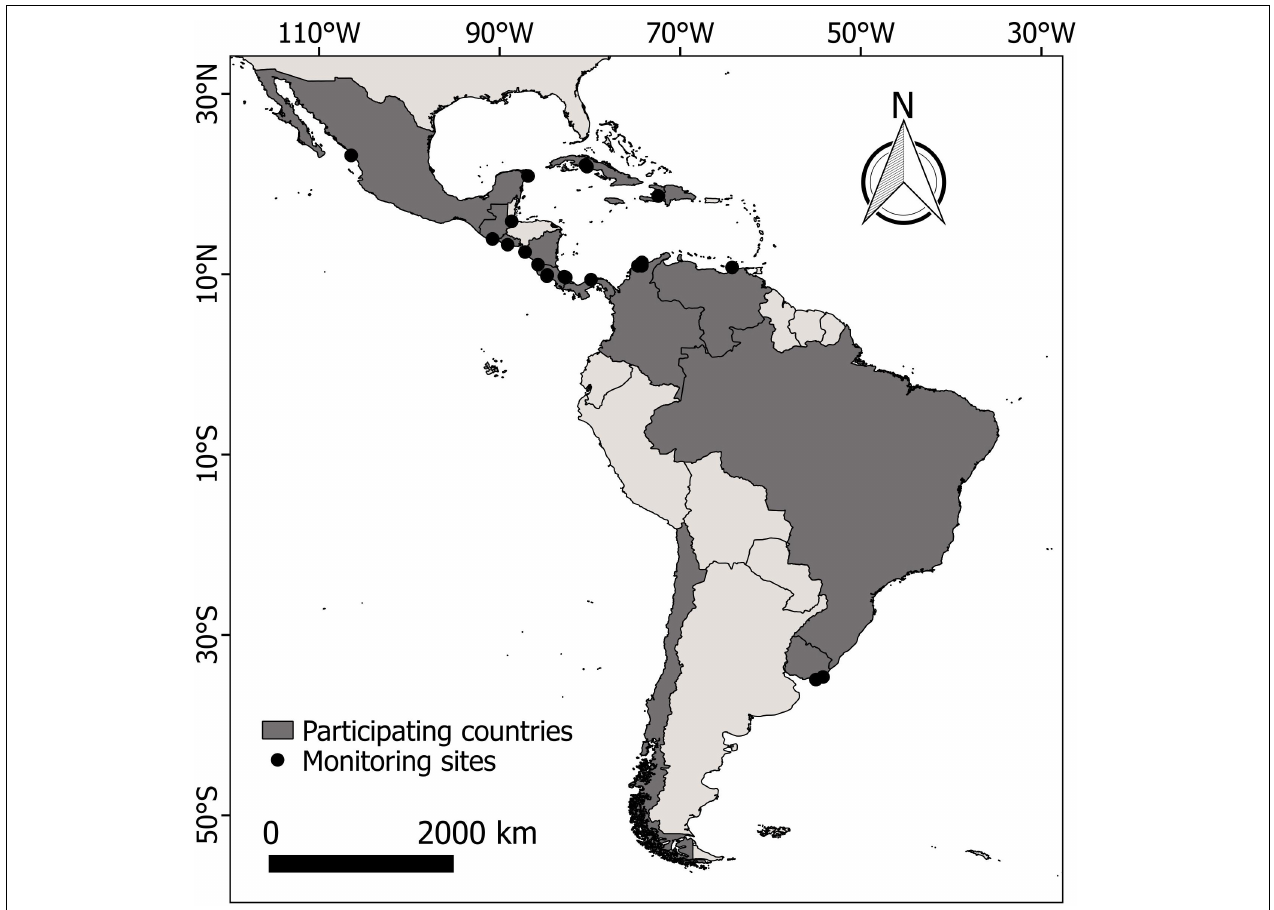
FIGURE 1 | Monitoring sites within the technical cooperation IAEA projects on HABs. Mexico: Mazatlán and Puerto Morelos, Cuba: Cienfuegos Bay and Ensenada de Guajimilco, Dominican Republic: Playa Caleta, Haiti: Port-au-Prince, Guatemala: Puerto Quetzal and Amatique Bay, El Salvador: all the coast, Nicaragua: Port of Corinto and El Ostional Bay, Costa Rica: Cahuita National Park, Gulf of Nicoya, Uvita Island and Puerto Vargas National Park, Panama: Punta Galeta, Colombia: Ciénaga Grande de Santa Marta and Chengue Bay, Venezuela: Cubagua Island, Uruguay: Punta del Este and La